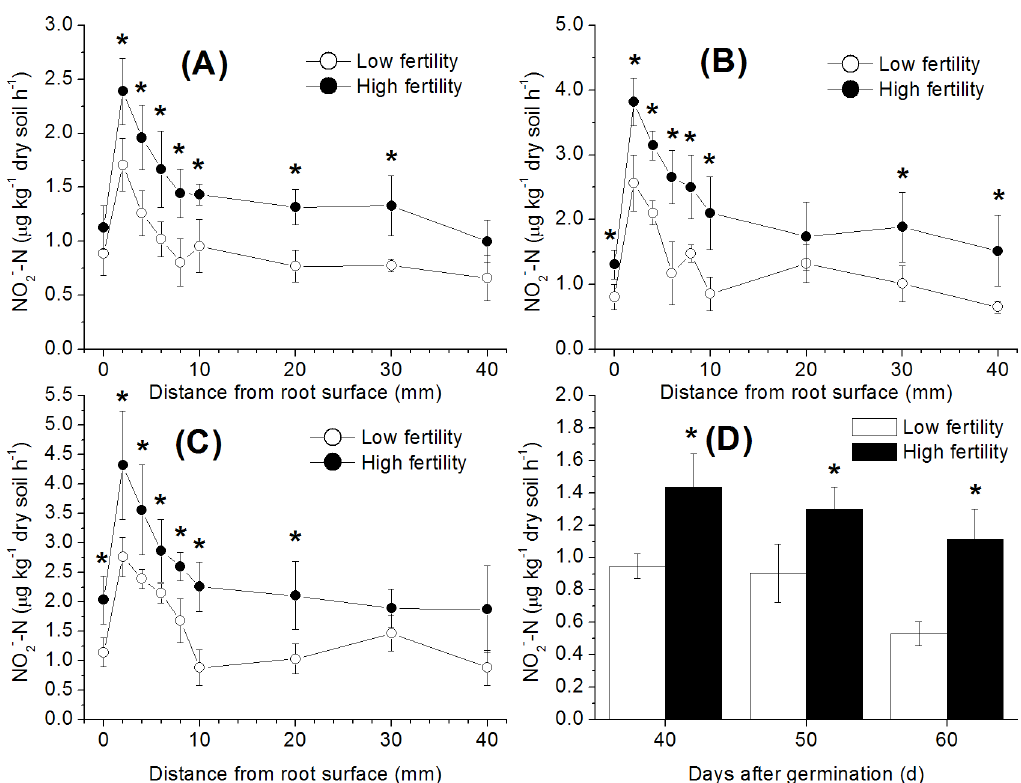
Figure 1. Nitrification activities measured at various distances from the rice root surface in paddy soils with different fertility levels (A) 40 d after germination, (B) 50 d after germination, (C) 60 d after germination, relative to the (D) control (without rice plants). The bars indicate 6 SD. Dots and bars with * indicate a significant difference (p , 0.05) between the two fertility levels.